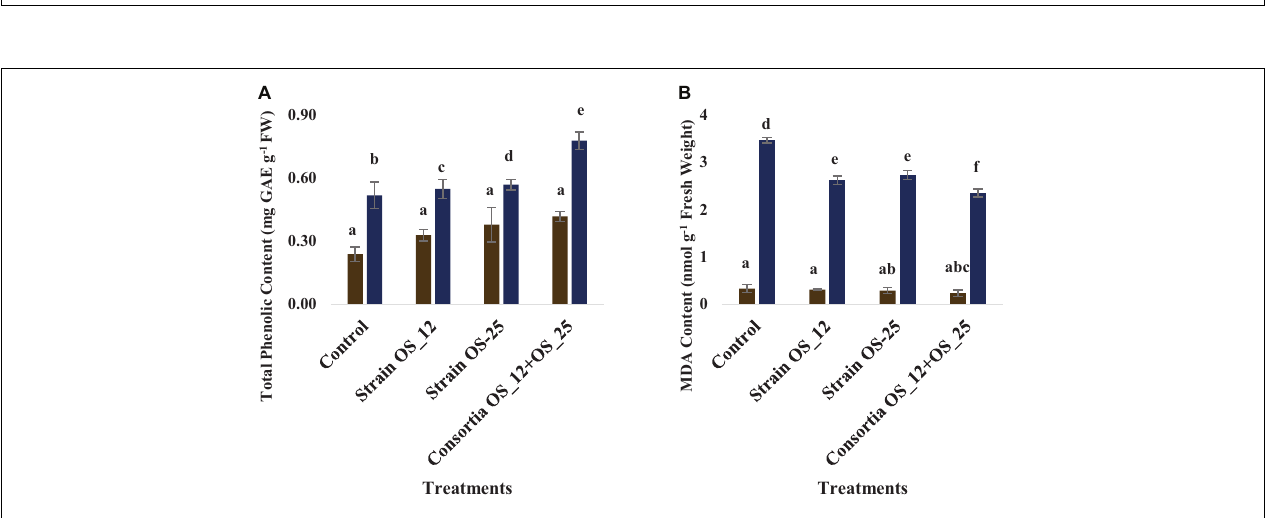
FIGURE 10 | Effect of pathogen and endophytic bacterial inoculation on activities of different defense related antioxidative enzymes (A) phenylalanine ammonia lyase (PAL), (B) polyphenol oxidase (PPO), (C) peroxidase (PO), (D) ascorbate oxidase (AO), and (E) catalase (CAT) under different treatment conditions. Columns represent Mean values ± Standard deviation ( n = 3). Dark yellow bar, normal conditions; blue bar, pathogen challenged conditions; Different letters indicate statistical difference between treatments (Turkey’s post test P < 0.05).